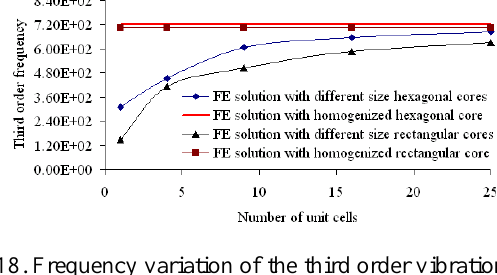
Fig.18. Frequency variation of the third order vibration with different size hexagonal and rectangular cores